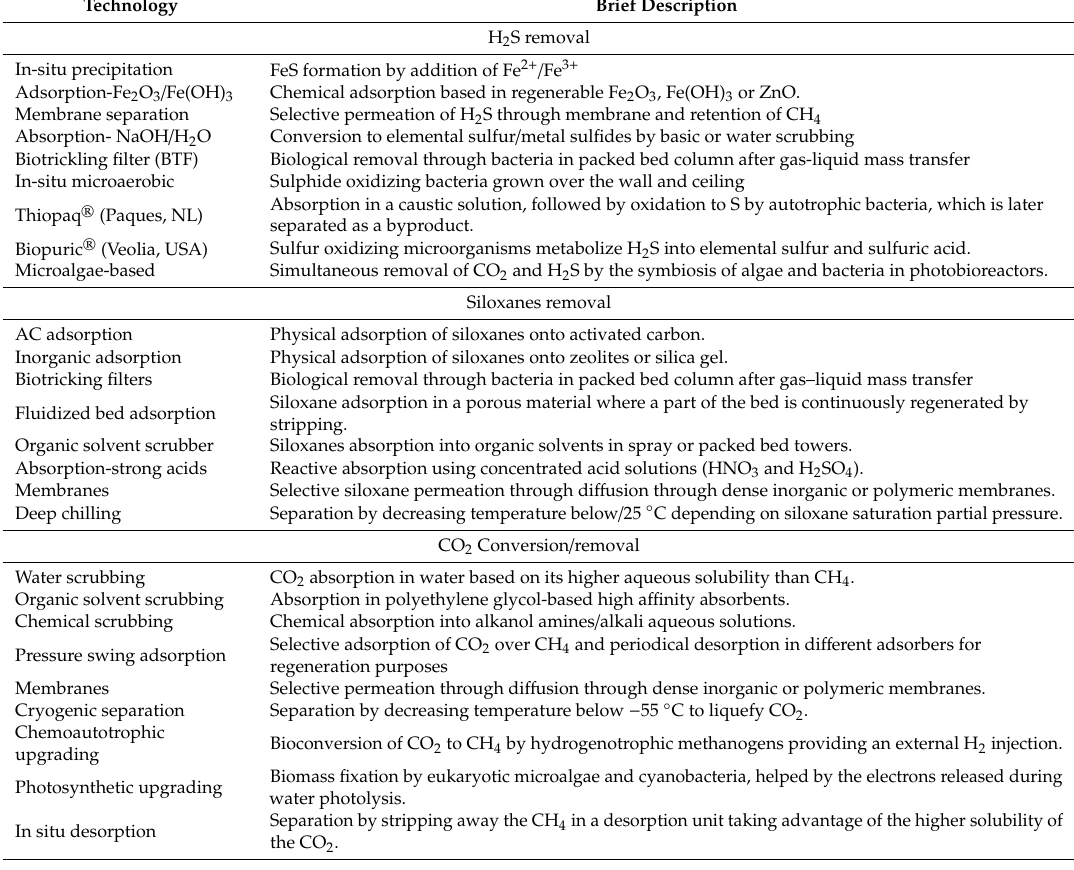
Table 2. Technologies contemplated within the environmental decision support system (EDSS) knowledge